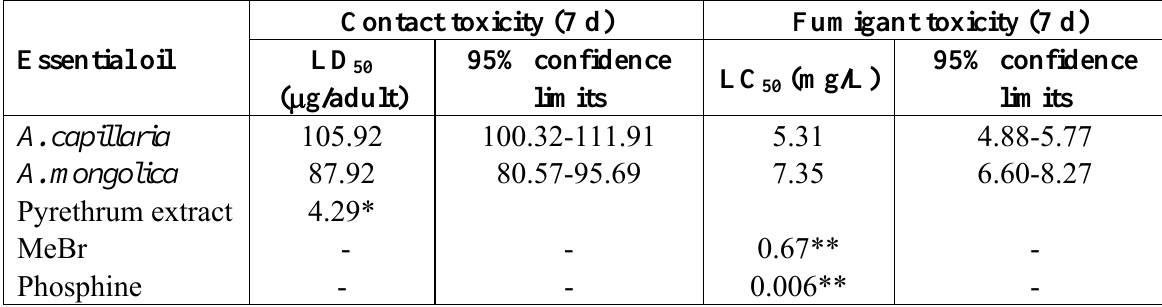
Table 3. Insecticidal activity of the essential oils of Artemisia capillaris and A. mongolica against Sitophilus zeamais